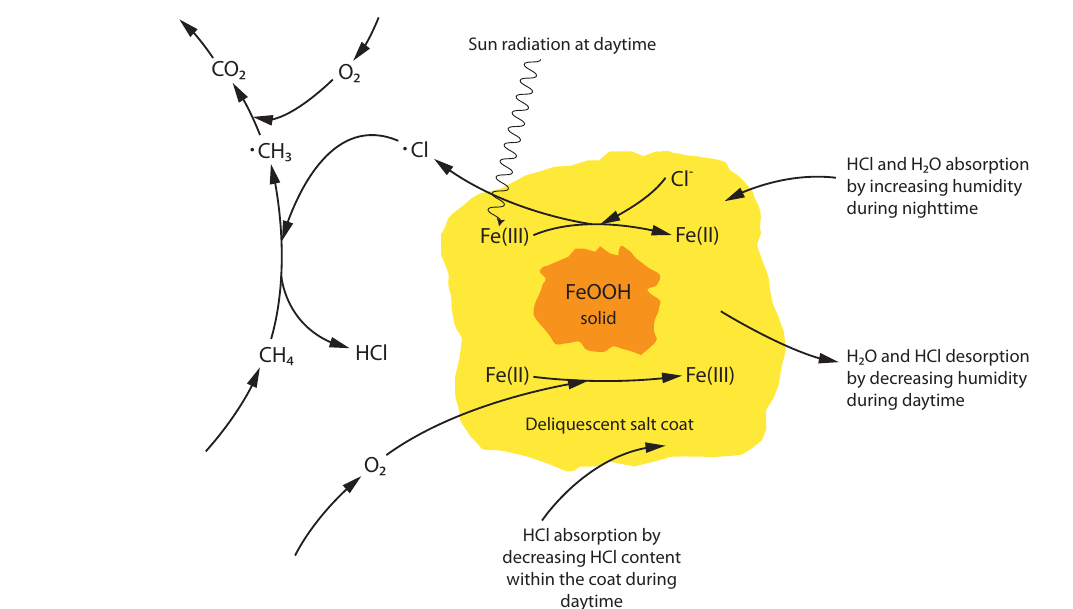
Figure 2. Simplified chemical reaction scheme of the generation of chlorine radicals by iron salt aerosols under sunlight radiation and the reaction of the chlorine radicals with atmospheric